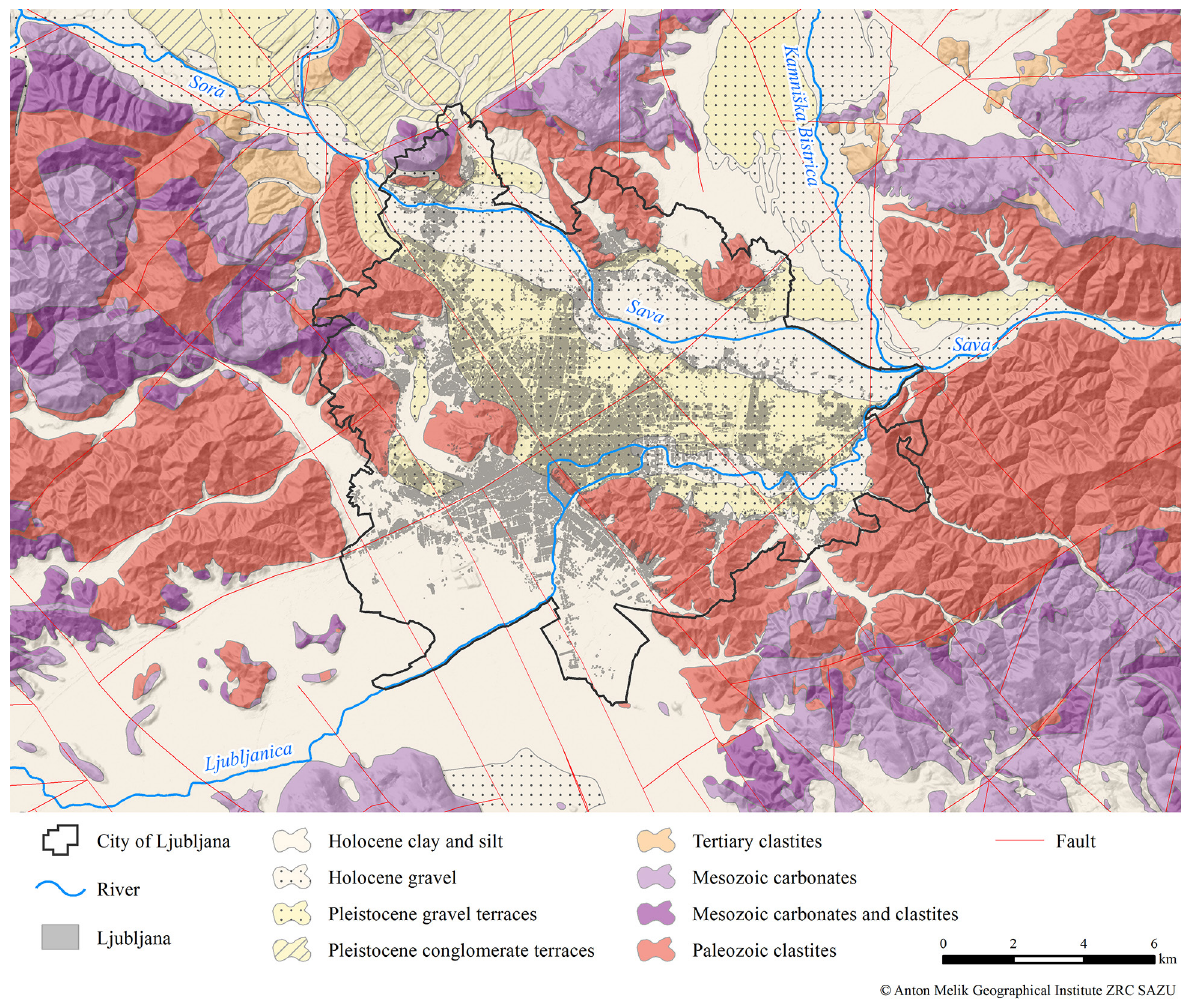
Fig. 2. In addition to hydrological conditions, various rock types in the area have determined the spatial growth of the city. The built-up area concentrated on the flat areas containing Pleistocene and Holocene gravel or conglomerate terraces to the north and Holocene clay and silt to the